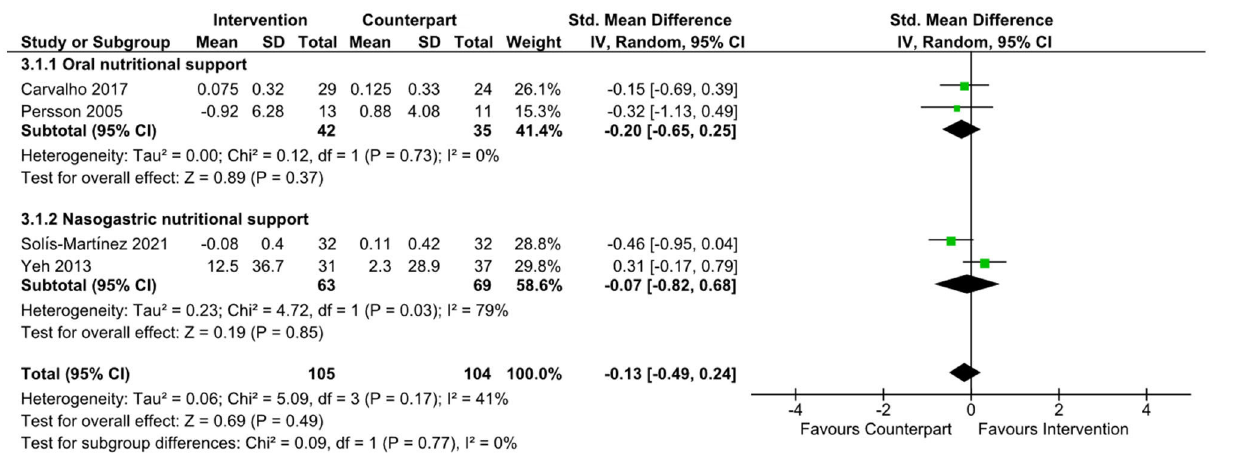
FIGURE 5 | Forest plot of standard mean difference in albumin levels.